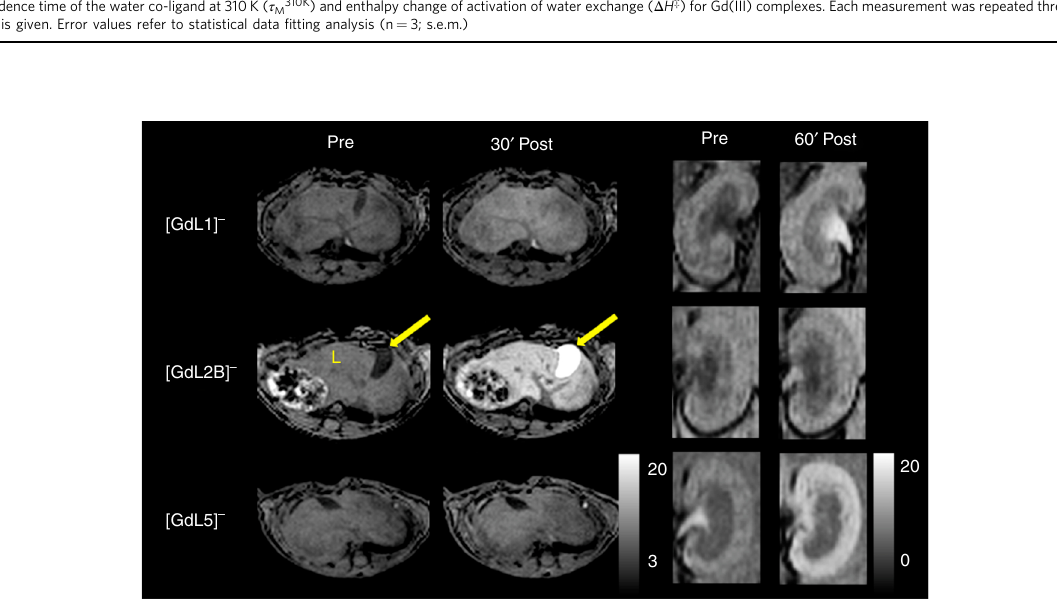
Fig. 7 MR imaging in mice. Dynamic T 1 -weighted MR images at 4.7 tesla in C57/Bl6 mice before, after 0.1 mmol per kg injection of [GdL1] − , [GdL2B] − and [GdL5] − . Axial images of the liver (L) and gall bladder (arrow) coronal images of the kidneys highlighting the differences in elimination route and organ enhancement among the complexes